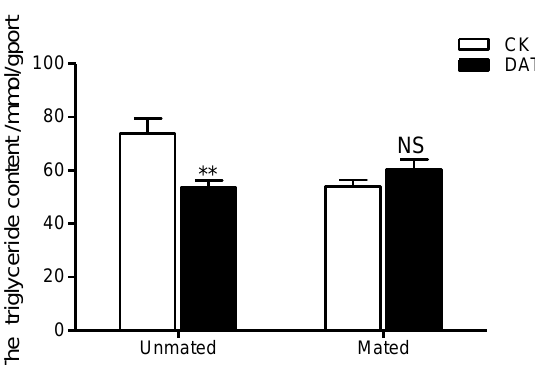
Figure 3. The triglyceride content of males was determined in the CK group (at 19 h after emergence) and DAT group (males treated with 0.01% diallyl trisulfide for 7 h at 12 h after emergence) both before and after mating. The data in the figure are presented as the mean ± SEM. Asterisks depict significant differences relative to the control treatment (NS, no significant difference, **, p < 0.01).